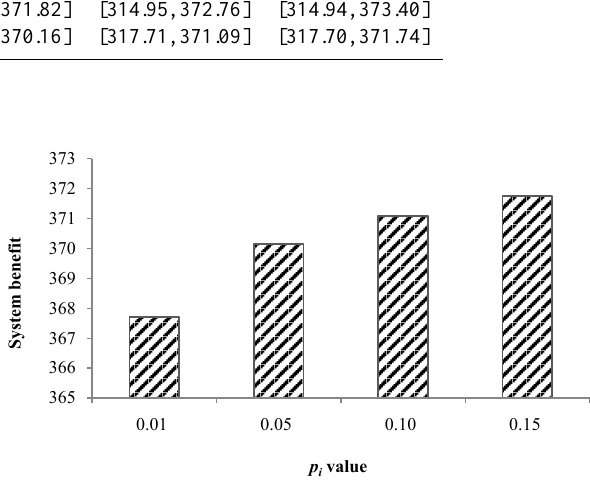
Fig. 4. System benefit under different p i values (upper bound).